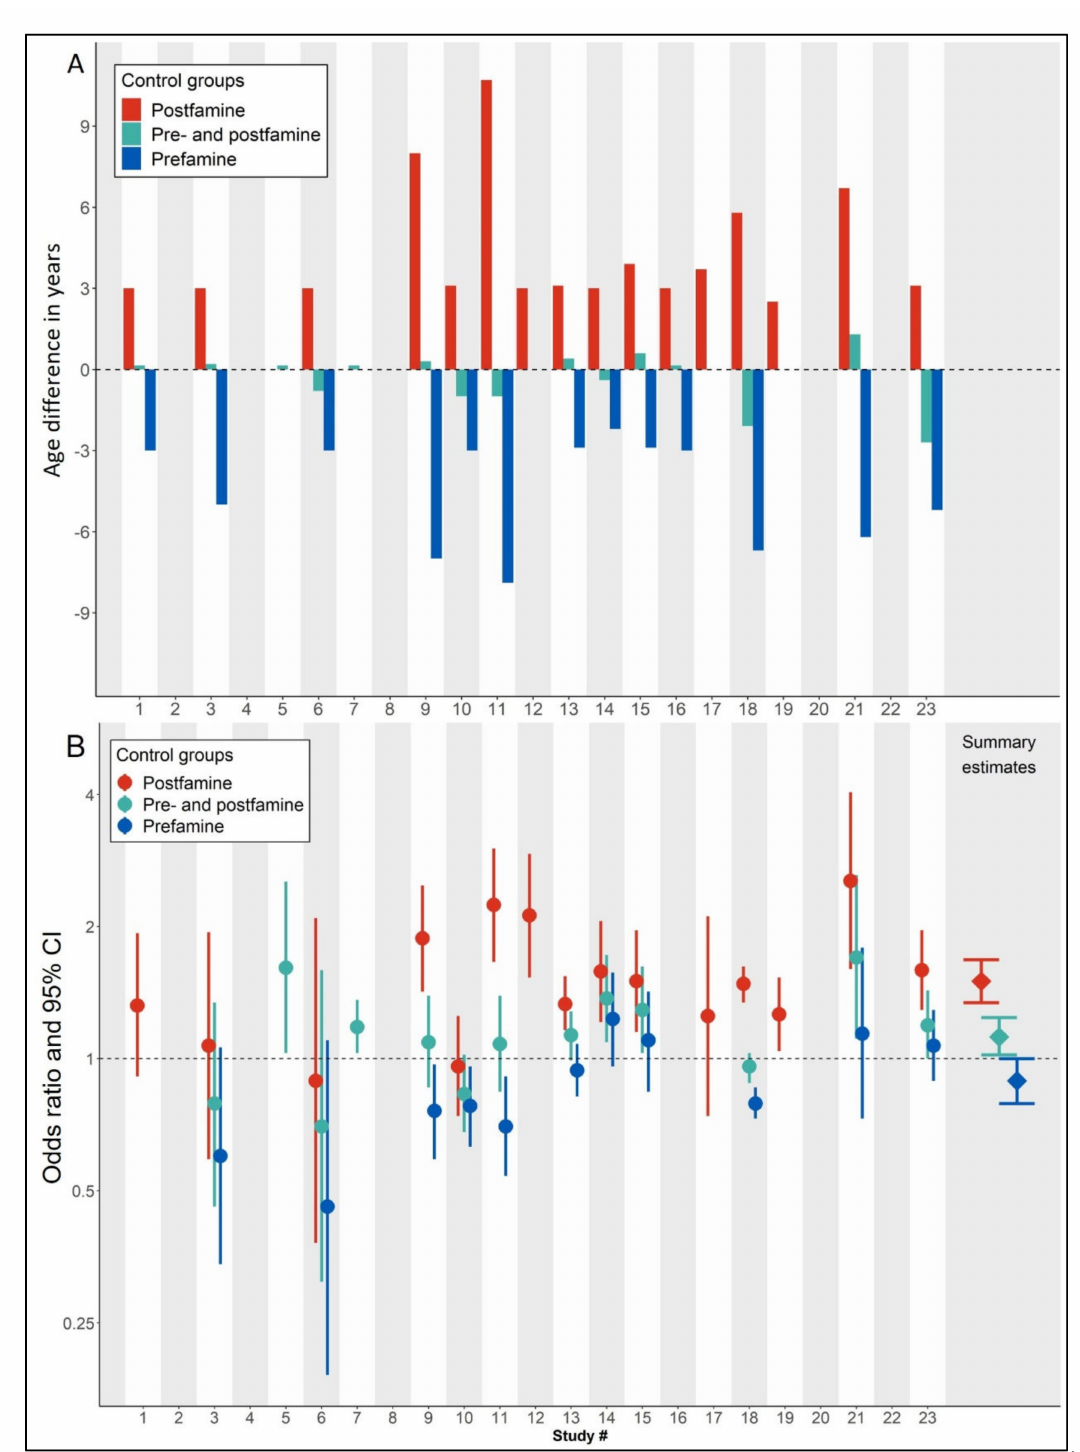
Figure 3. Age differences and effect estimates comparing the famine birth group to different control groups. ( A ) Age differences comparing famine births to different control groups, including the postfamine births, prefamine births, and combined pre- and postfamine births. ( B ) Effect estimates comparing famine births to different control groups. Odds ratios were calculated based on random- effects models and numbers of T2D cases and populations at risk. Summary estimates were generated based on the random-effects